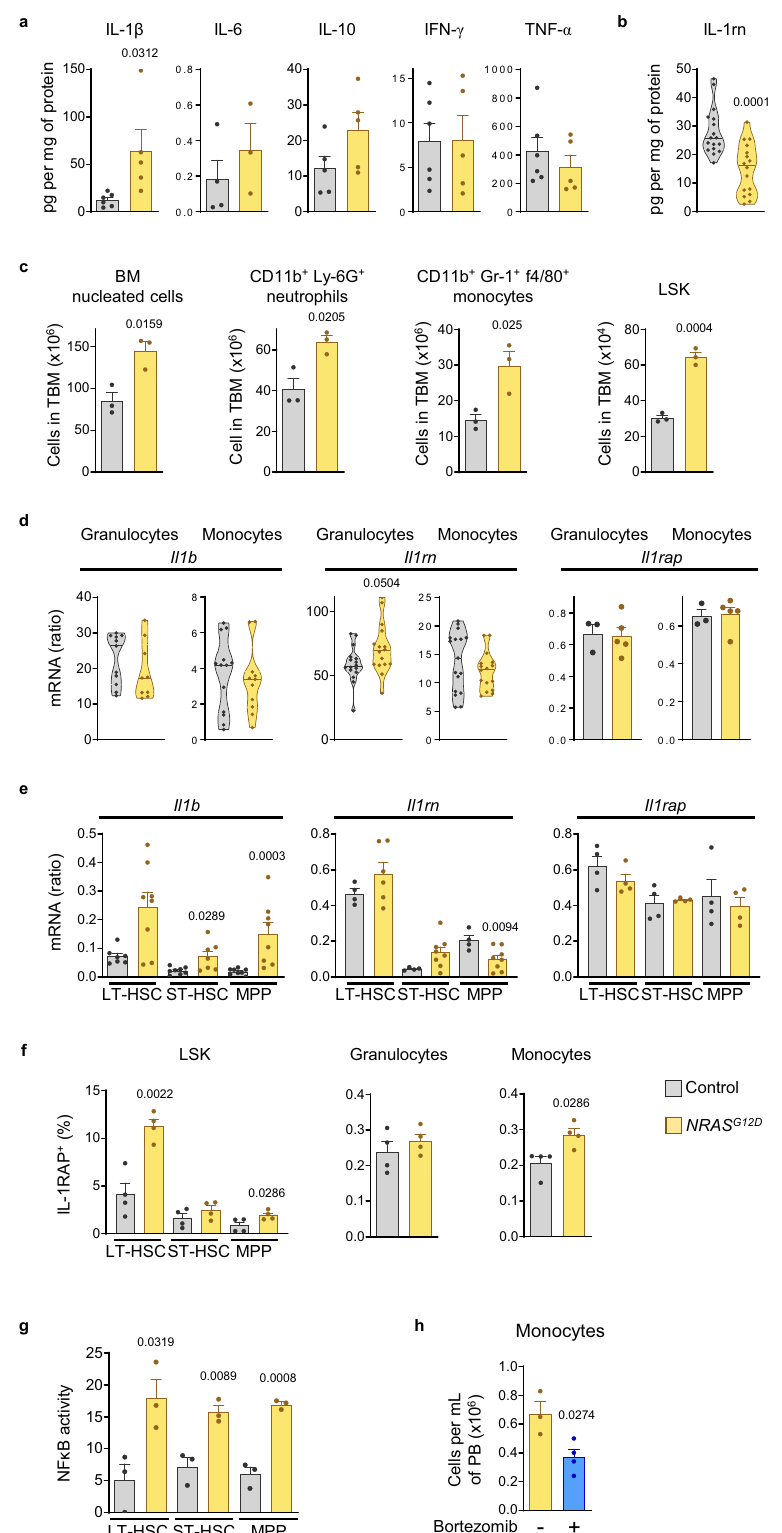
results 6 . Conversely,boosting IL-1RNimproved signs ofdiseaseinthe NRAS G12D -driven myeloid pre-leukemia mouse model and in mouse xenografts from AML patients. IL-1RN boost or IL-1 β blockade through treatment with canakinumab, currently under Phase II trial for the treatment of low and intermediate risk MDS and